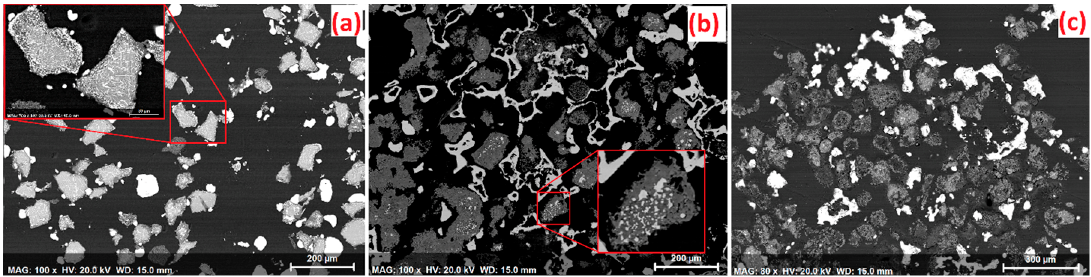
Figure 3. Backscattered electron micrographs of the reduced products from the tests with ( a ) no additive, ( b ) 10 wt %, and ( c ) 30 wt % CaCl 2 addition.